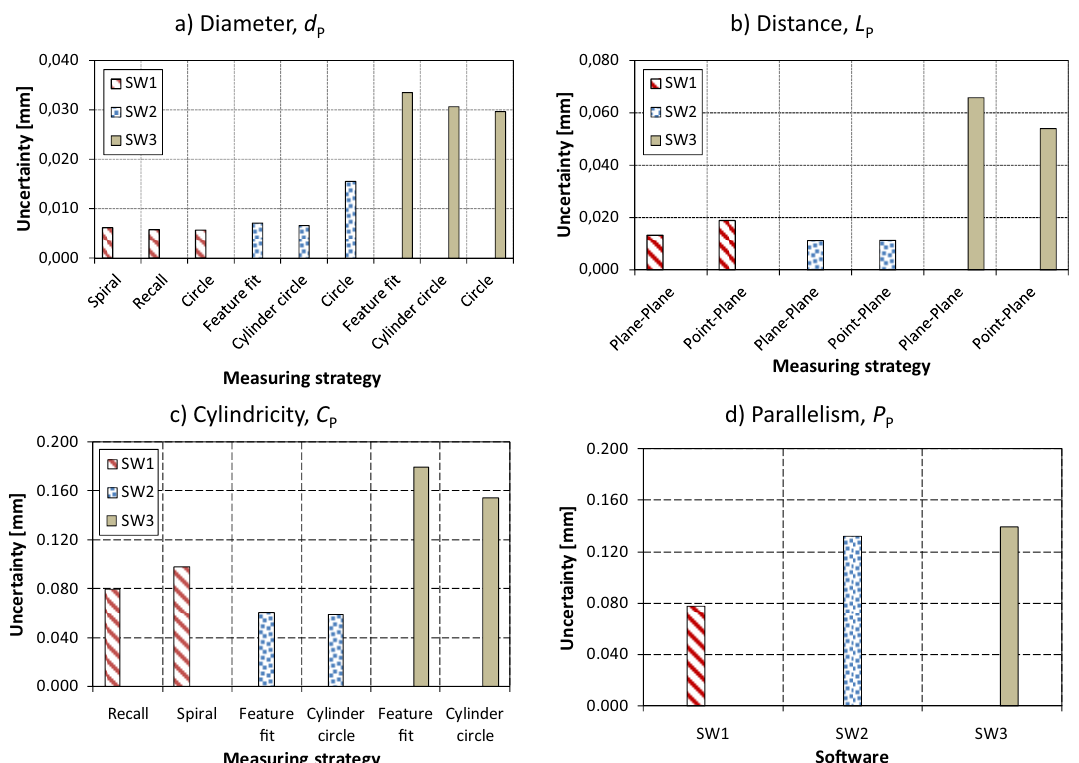
Fig. 3. Expanded uncertainties at 95% confidence level for measurements performed on the pipe connector. Measurement uncertainties are calculated according to equation